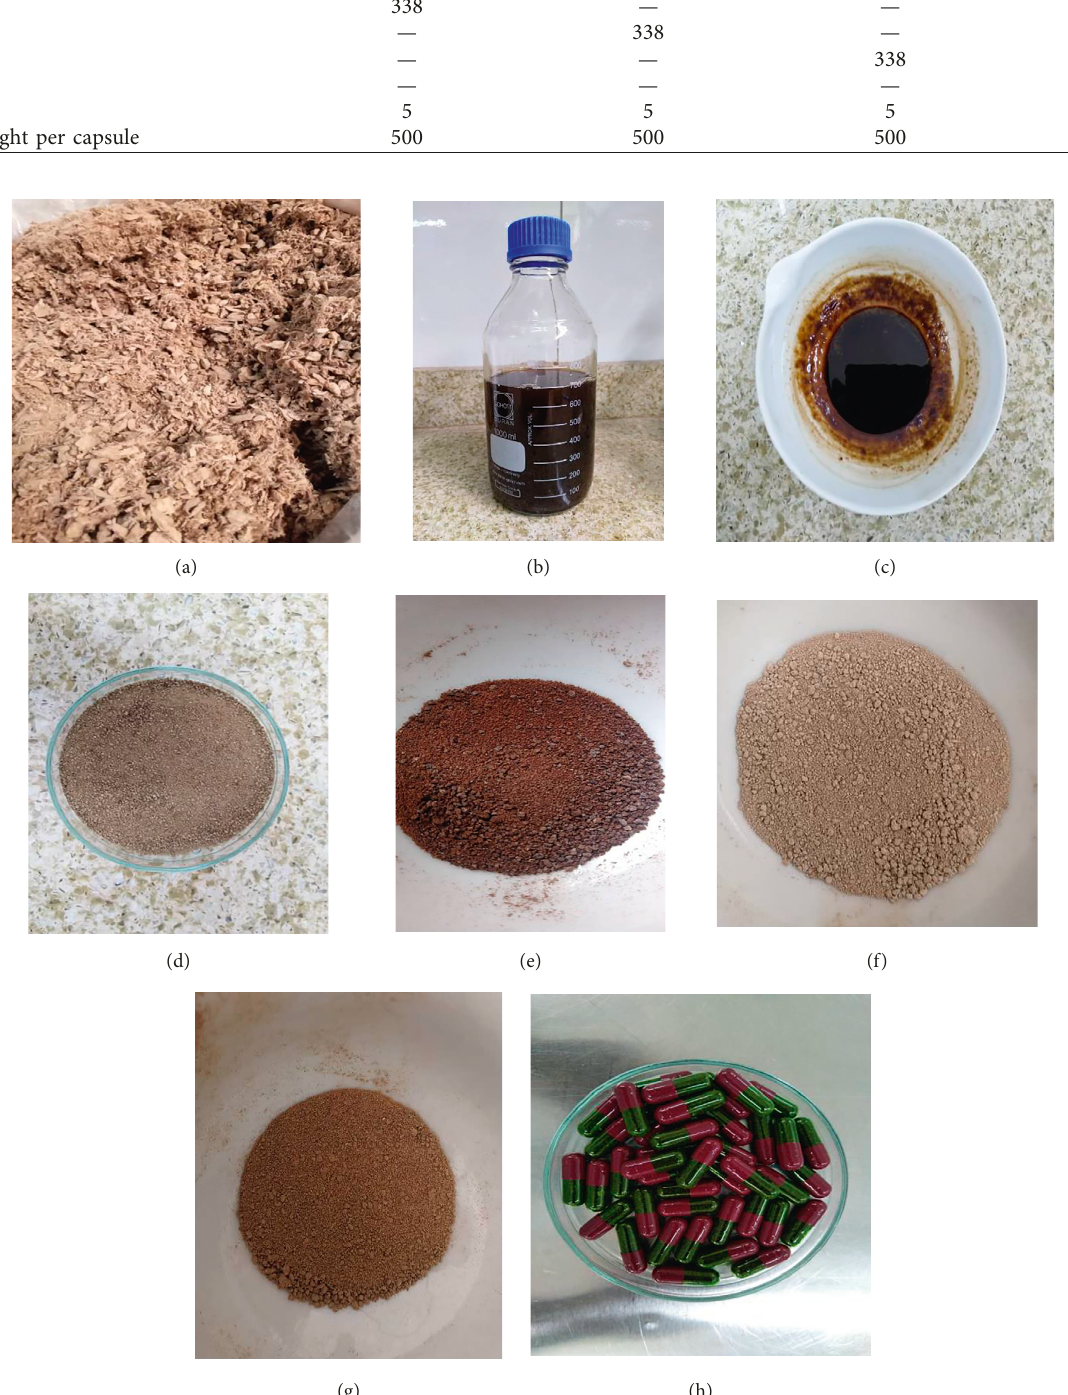
Figure 1: Milled stem bark of Antiaris africana (a). Prepared decoction/aqueous extract (b). Concentrated extract (c). A01 granules (d). Granules for A02 (e). Granules for A03 (f), Granules for A04 (g). Encapsulated granules (h).